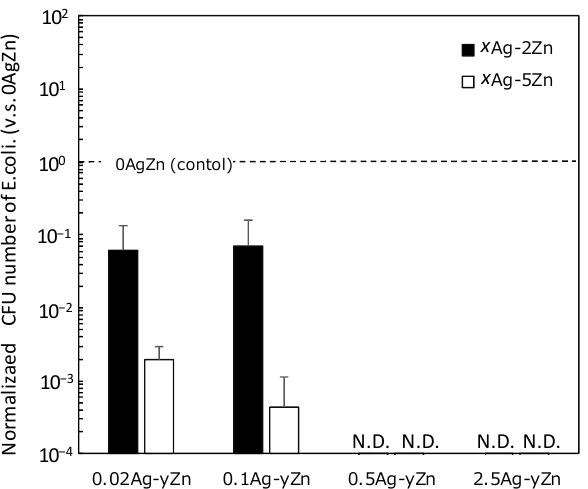
Figure 3. Antibacterial properties of MAO-treated specimens containing both Ag and Zn. Measurements were performed on five equally conditioned specimens ( n = 5). Results in the viable bacterial count < 1 are denoted as “N.D.”.